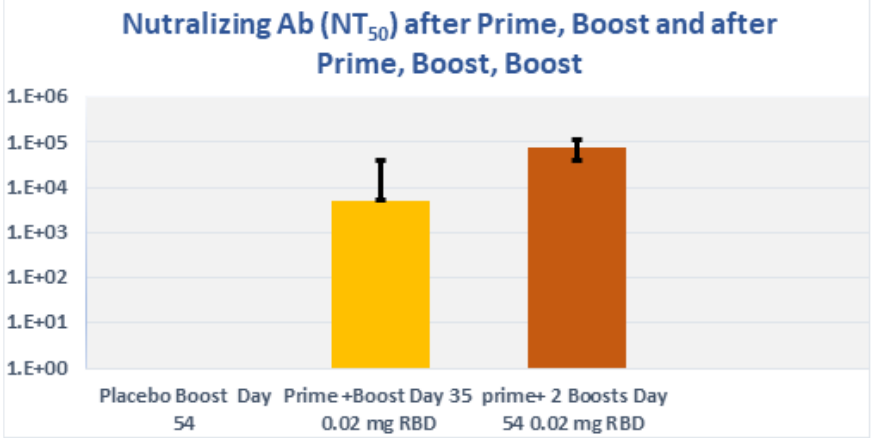
Figure 9. SARS-CoV-2 neutralizing titer generated by Alhydrogel ® ‘85’ adjuvanted C1-RBD-C-tag antigen in K18-hACE2 transgenic C57BL/6J mice. Neutralizing titers determined at day 35, 14 days after the second immunization and neutralizing titers determined at day 54, 13 days after the third immunization. Control mice groups included 640 µg of Alhydrogel ® ‘85’ adjuvant alone without vaccine RBD antigen.